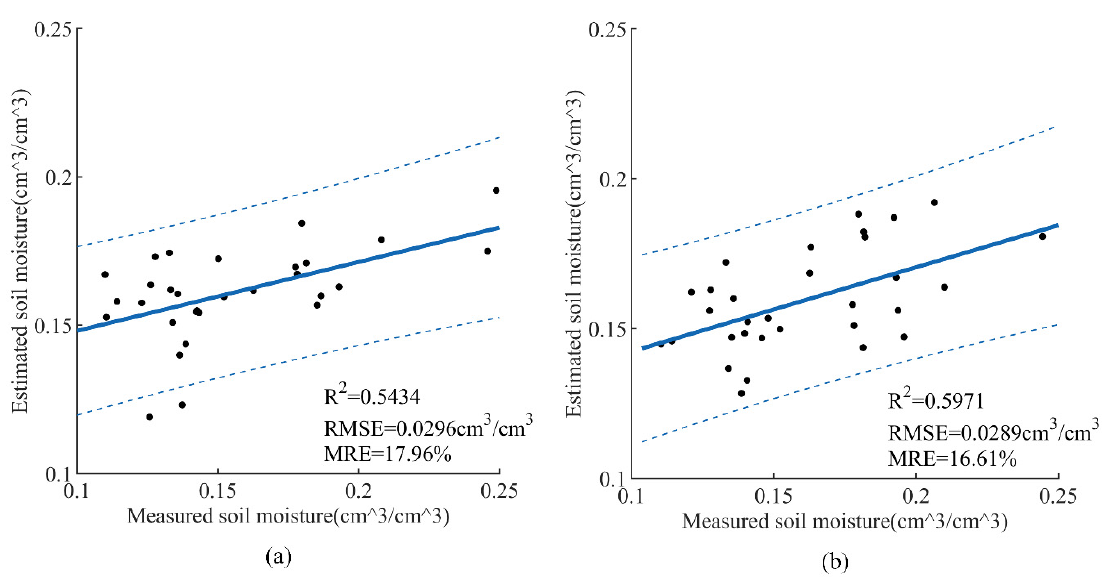
Figure 6. SMC retrieval results of the Oh model before and after removing vegetation: ( a ) before removing vegetation, ( b ) after removing vegetation.